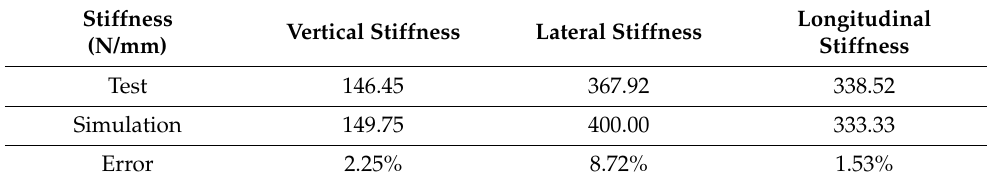
Table 3. The stiffness of the FS-NPT sample.